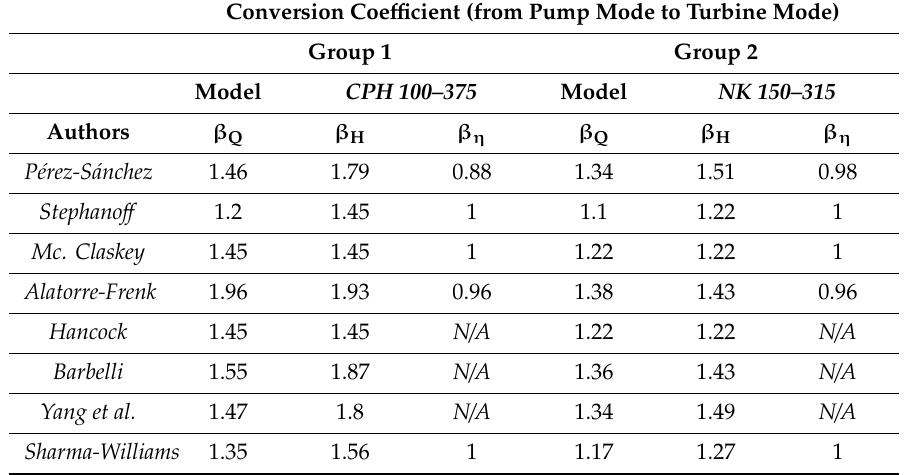
Table 13. Conversion coe ffi cients from pump mode to turbine mode for each group of point #7.